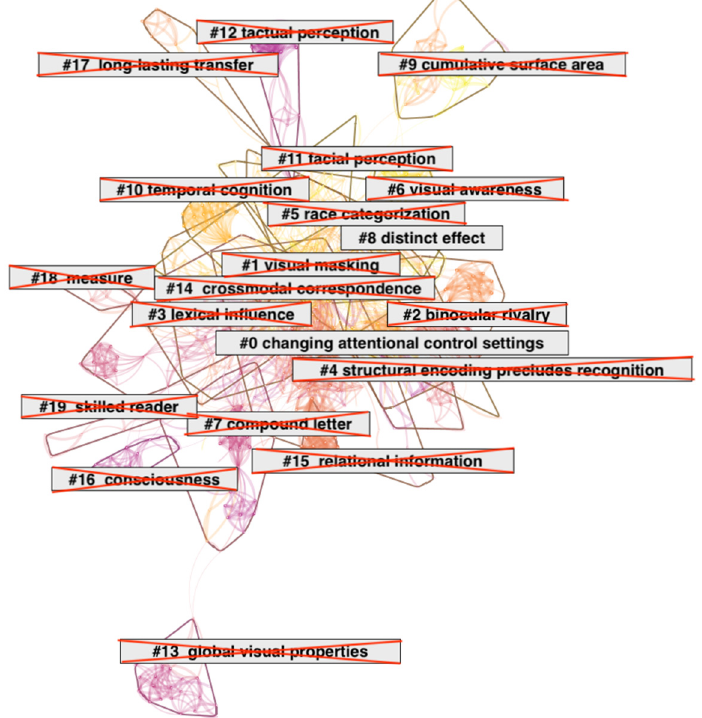
Figure 7. Co-citation clusters of the network for the first step of the review, visual processing. Table 6. Cluster information and documents for the first step of the systematic review, visual pro- cessing.